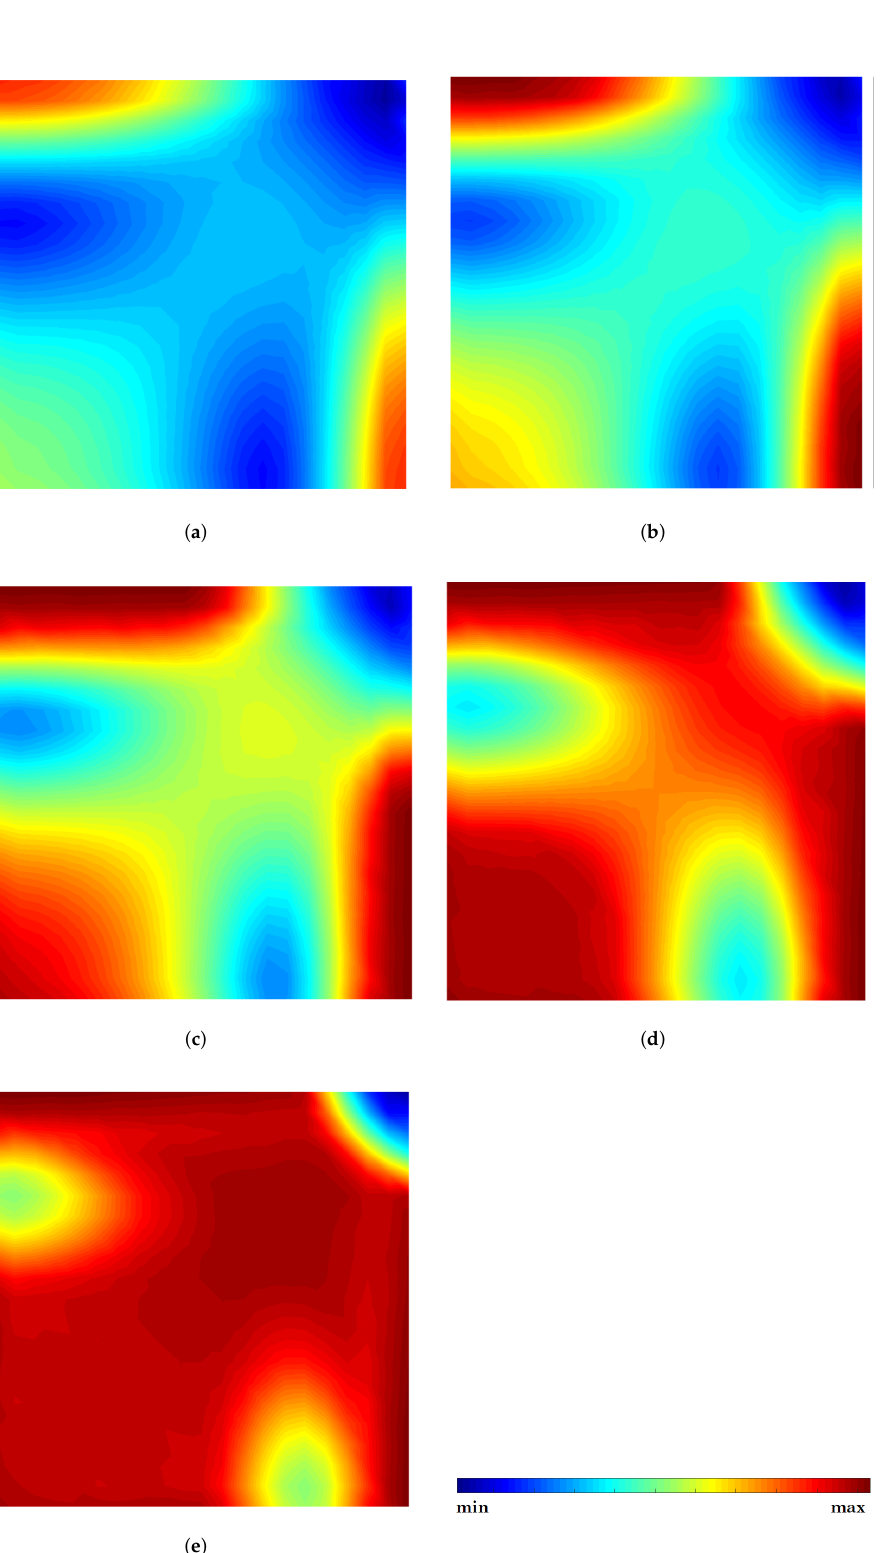
Figure 12. Effective von Mises stress distribution maps obtained with FEM for five load increments considering the clamped plate. For each load increment, the minimum and maximum effective stresses are: ( a ) f = 1053.52 KN/m 2 : σ min = 0 MPa; σ max = 170 MPa. ( b ) f = 1527.61 KN/m 2 : σ min = 0 MPa; σ max = 205 MPa. ( c ) f = 2001.69 KN/m 2 : σ min = 0 MPa; σ max = 210 MPa. ( d ) f = 2475.78 KN/m 2 : σ min = 0 MPa; σ max = 215 MPa. ( e ) f = 2791.83 KN/m 2 : σ min = 0 MPa; σ max = 220